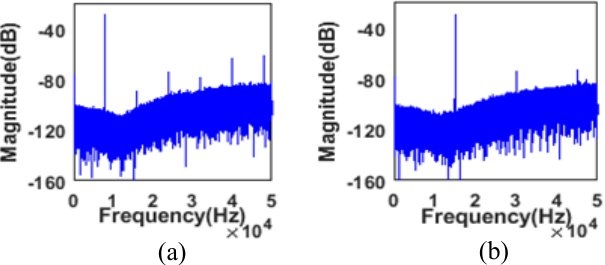
Figure 15. Spectrums of the output signal of the second-order Σ∆ modulator with signal observation off and fixed control voltages when either ( a ) an 8 kHz sinusoidal wave is input or ( b ) a 15 kHz sinusoidal wave is input.